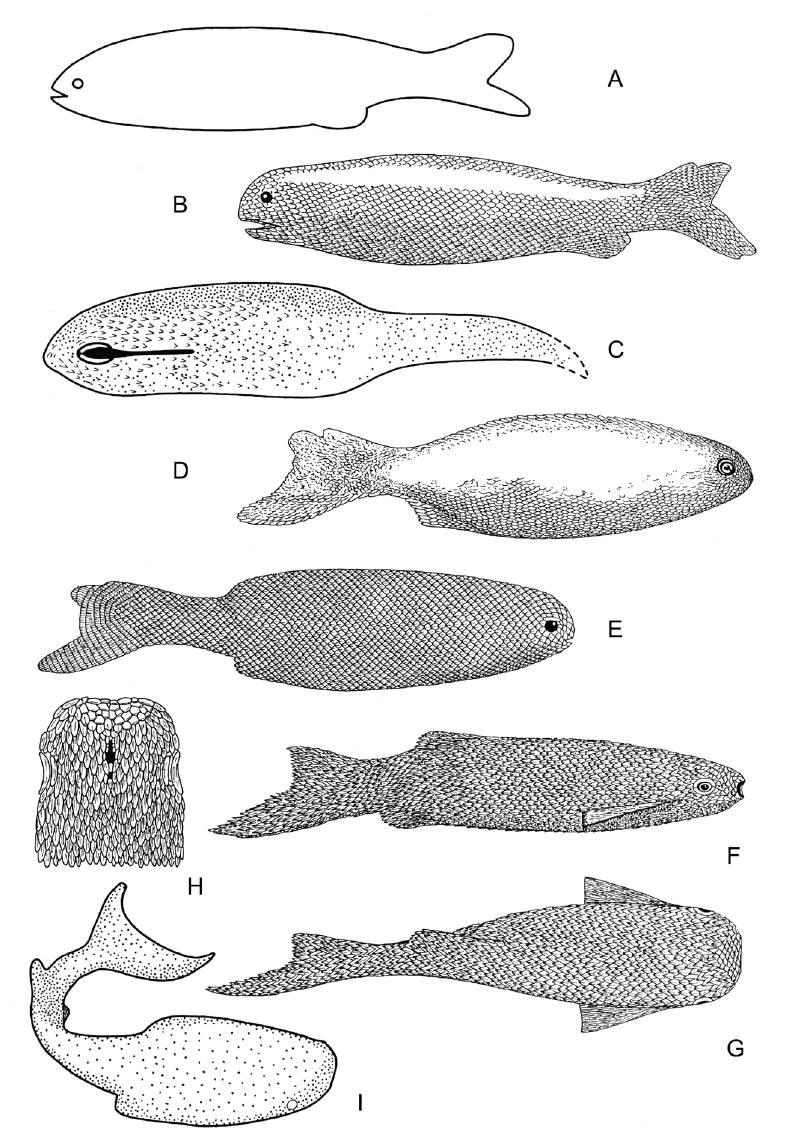
Fig. 1. History of reconstructions of body shape of Phlebolepis elegans . A , Westoll 1945, fig. 5A; B , Bystrow 1949 (figure